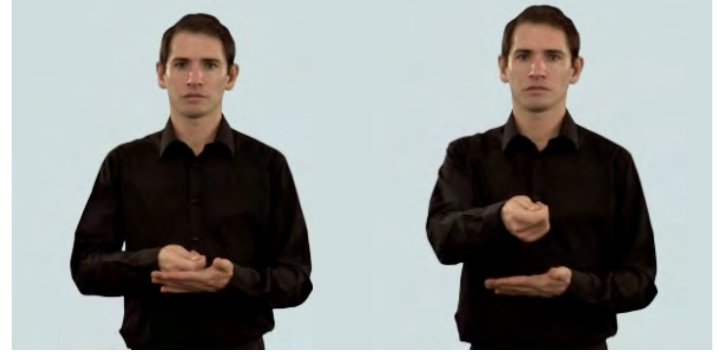
Figure 3. Indicating verb pay in